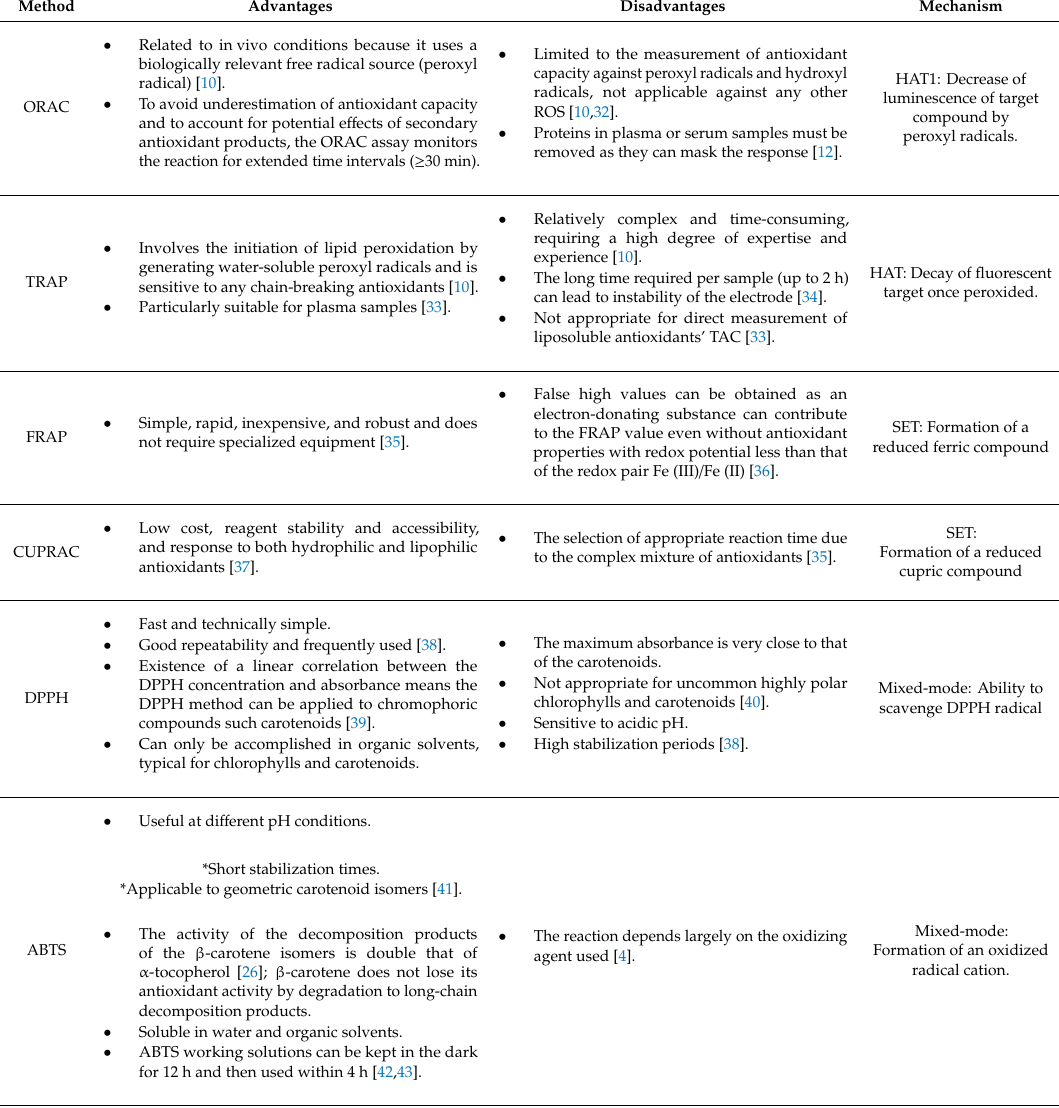
Table 1. Chemical methods applied to measure the antioxidant activity of chlorophylls and carotenoids. Method Advantages Disadvantages Mechanism